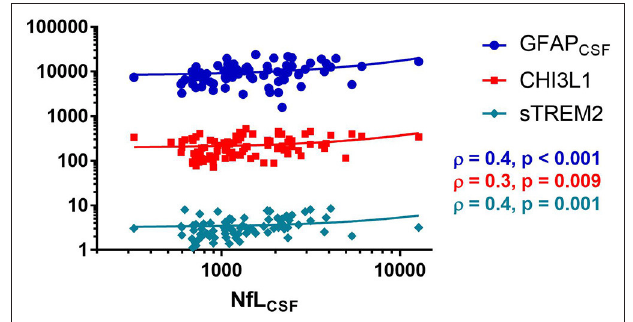
FIGURE 6 | Spearman correlation between neurofilaments light chain (NfL), glial fibrillary acidic protein (GFAP), chitinase 3 like 1 (CHI3L1), and soluble triggering receptor expressed on myeloid cells 2 (sTREM2), ρ (Spearman rho).